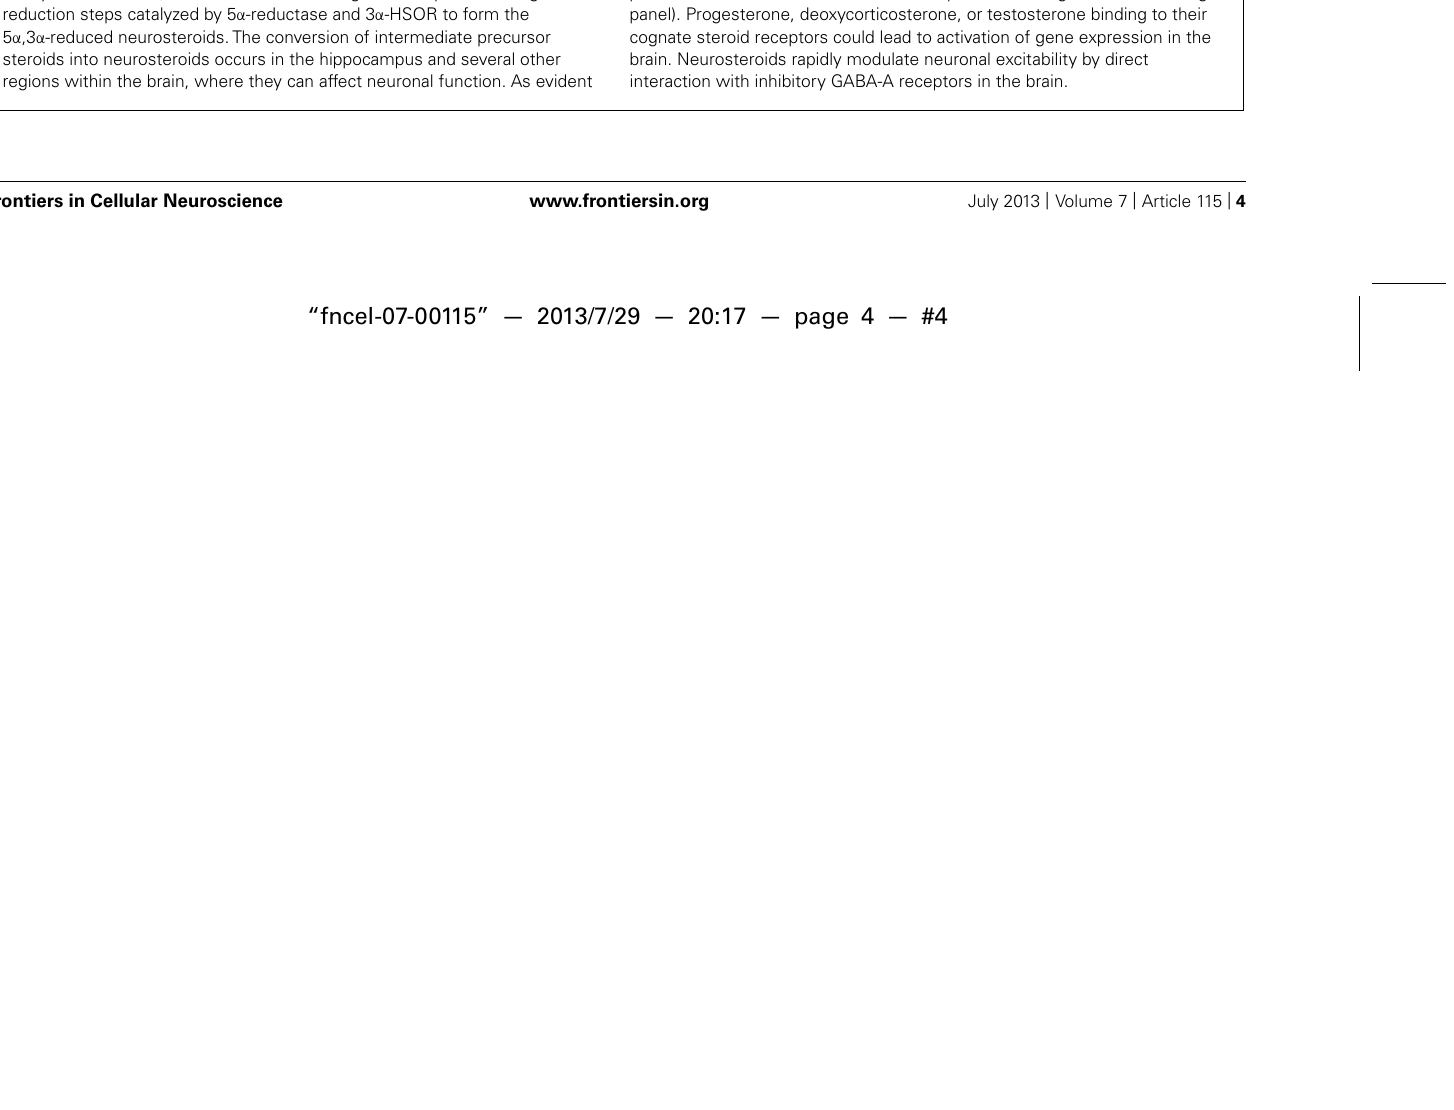
FIGURE 2 | Biosynthesis and targets of steroid hormones and neurosteroids in the brain. Enzymatic pathways for the production of three prototype neurosteroids allopregnanolone,THDOC, and androstanediol are illustrated from cholesterol. Steroid hormones progesterone, deoxycorticosterone, and testosterone undergo two sequential A-ring reduction steps catalyzed by 5 α -reductase and 3 α -HSOR to form the 5 α ,3 α -reduced neurosteroids.The conversion of intermediate precursor steroids into neurosteroids occurs in the hippocampus and several other regions within the brain, where they can affect neuronal function. As evident